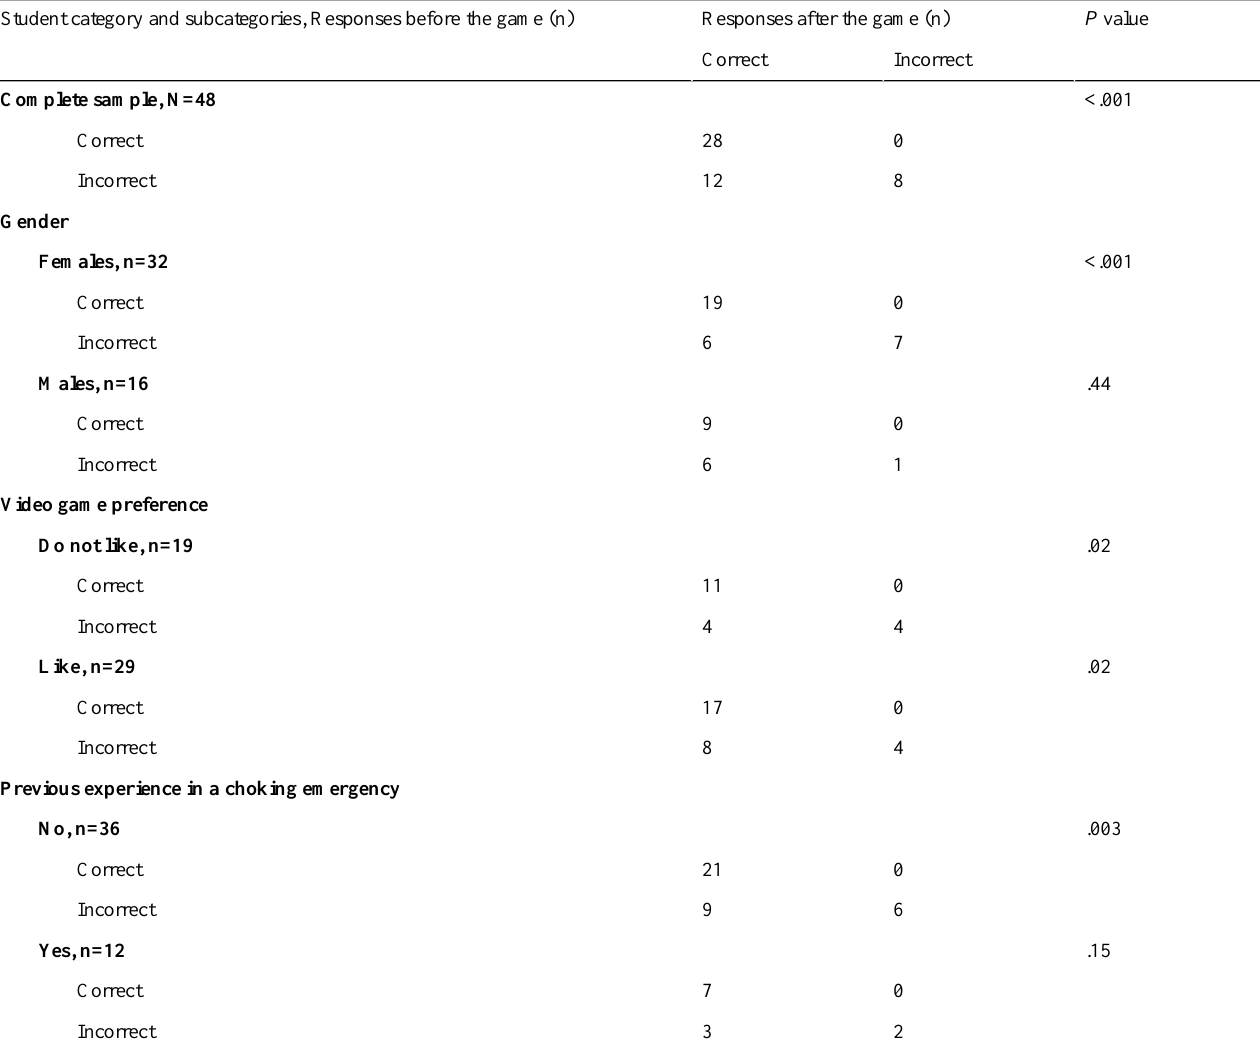
Table 6. Statistical analysis of the responses of the action in case of choking before and after playing the